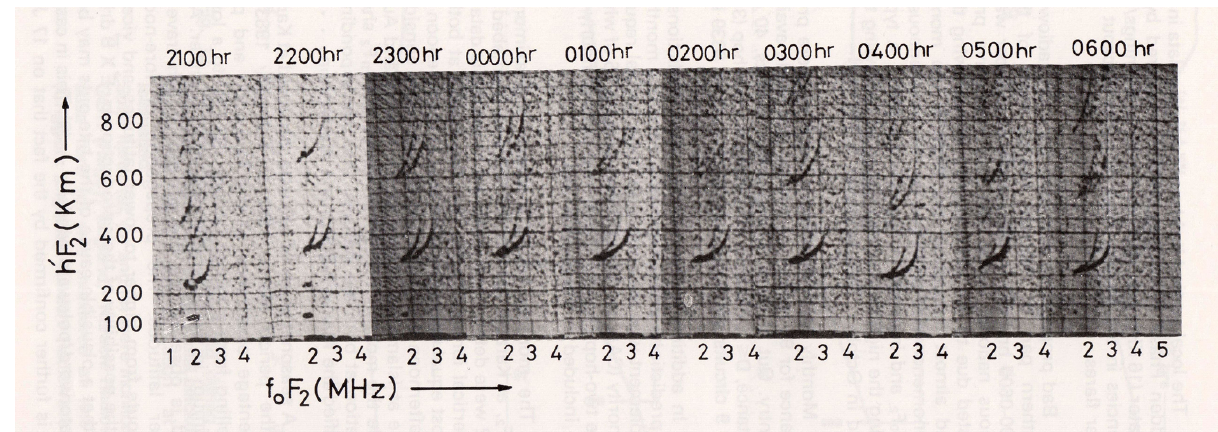
Figure 6. A composite image of an ionogram showing narrowing in the frequency band on 1 and 2 October 1985. (Image credits: SUPARCO, 1986; available at SUPARCO library.)